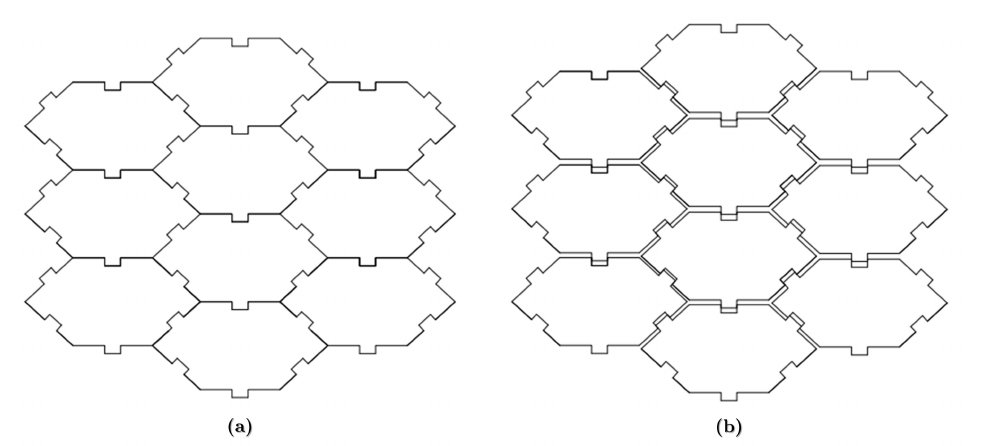
Figure 17. Interlocking hexagon structure: ( a ) fully densified; ( b ) partially